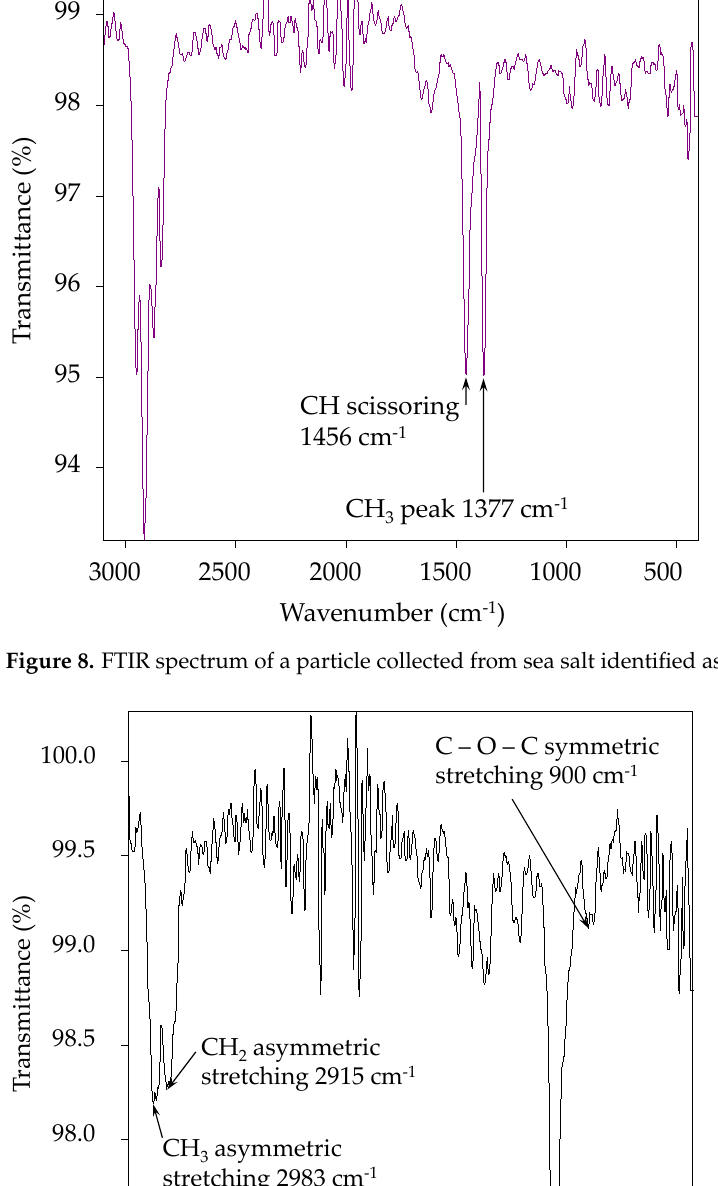
Figure 7. FTIR spectrum of a particle collected from the NZ green-lipped mussel digestive tract identified as PP.